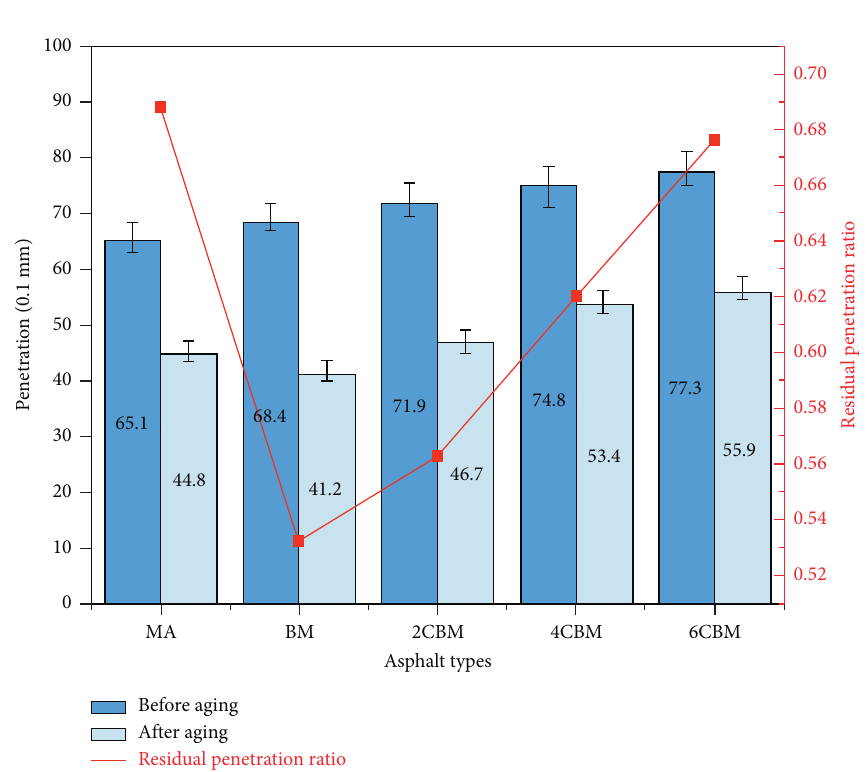
Figure 3: Effect of organic nano-CaCO 3 on the penetration of bioasphalt before and after aging.